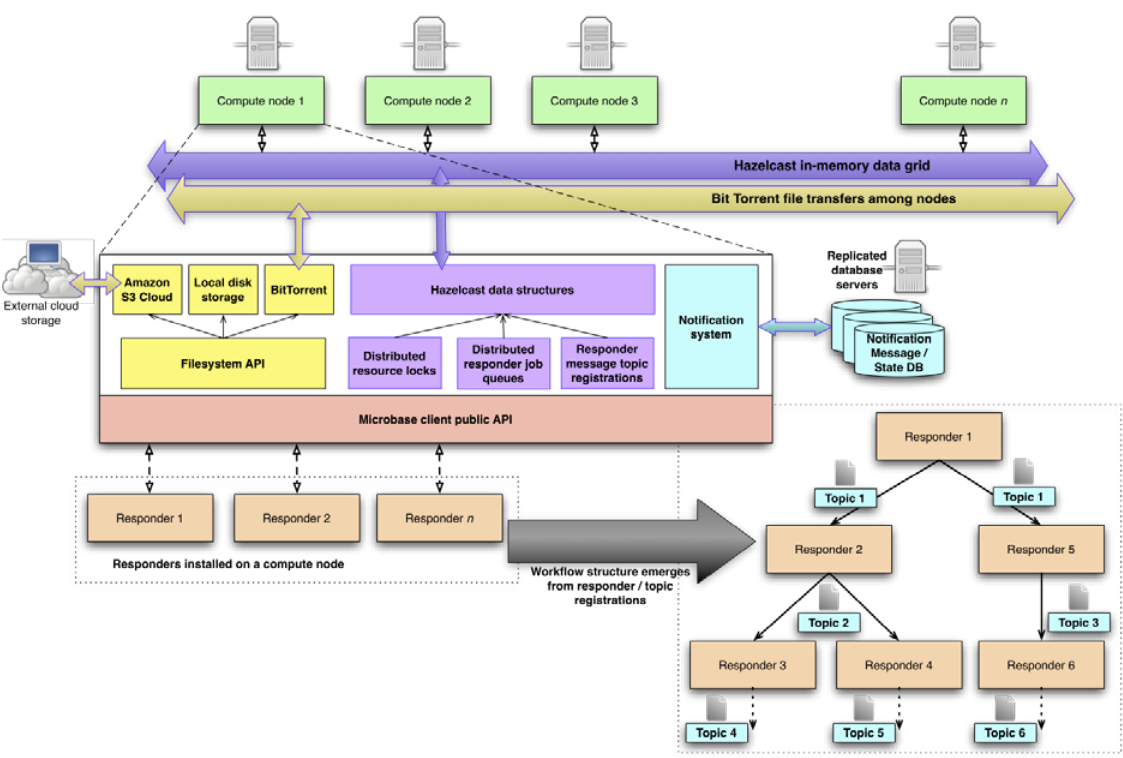
Figure 1: A summary of the Microbase2.0 client architecture and its operation. Microbase2.0 provides APIs for a number of core services that facilitate workflow orchestration: the event notification system (blue), file storage and distribution system (yellow), and various distributed data structures that provide task scheduling and monitoring operations (purple). The Microbase2.0 client is installed on available computers (green). Every compute node is symmetric – there are no special nodes such as a ‘master node’. In addition to the Microbase2.0 client, compute nodes may have one or more user-written components, termed ‘responders’, installed. A responder may register its interest in a particular message topic, and is activated by the system when a suitable message arrives in the notification system. A workflow is formed when messages generated by one responder are passed as input to another responder (bottom